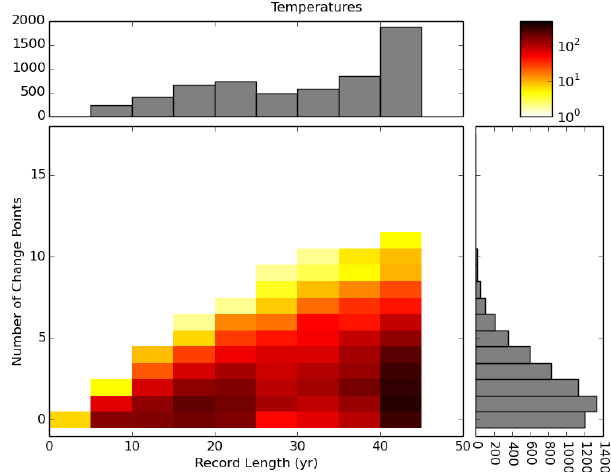
Figure 4. Main panel: the distribution of the stations with number of change points and record length. Histograms show the distribu- tion of stations with record length (top) and with change point num- ber (right), which are the projections onto the x and y axes of the main panel, respectively. The colour bar (top right) is on a logarith- mic